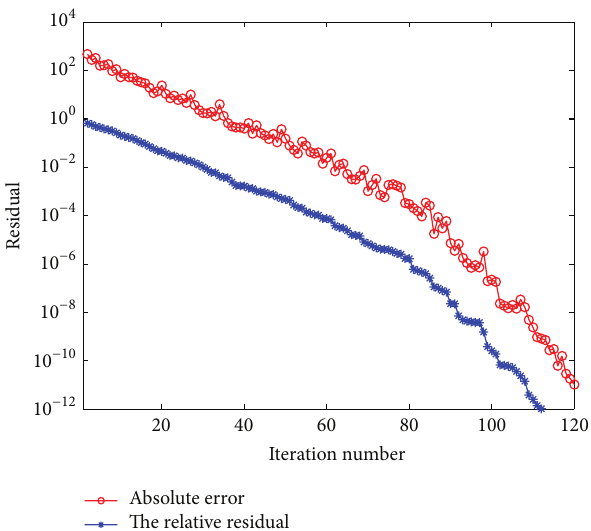
Figure 1: The relative error of solution and the residual for Example 1.